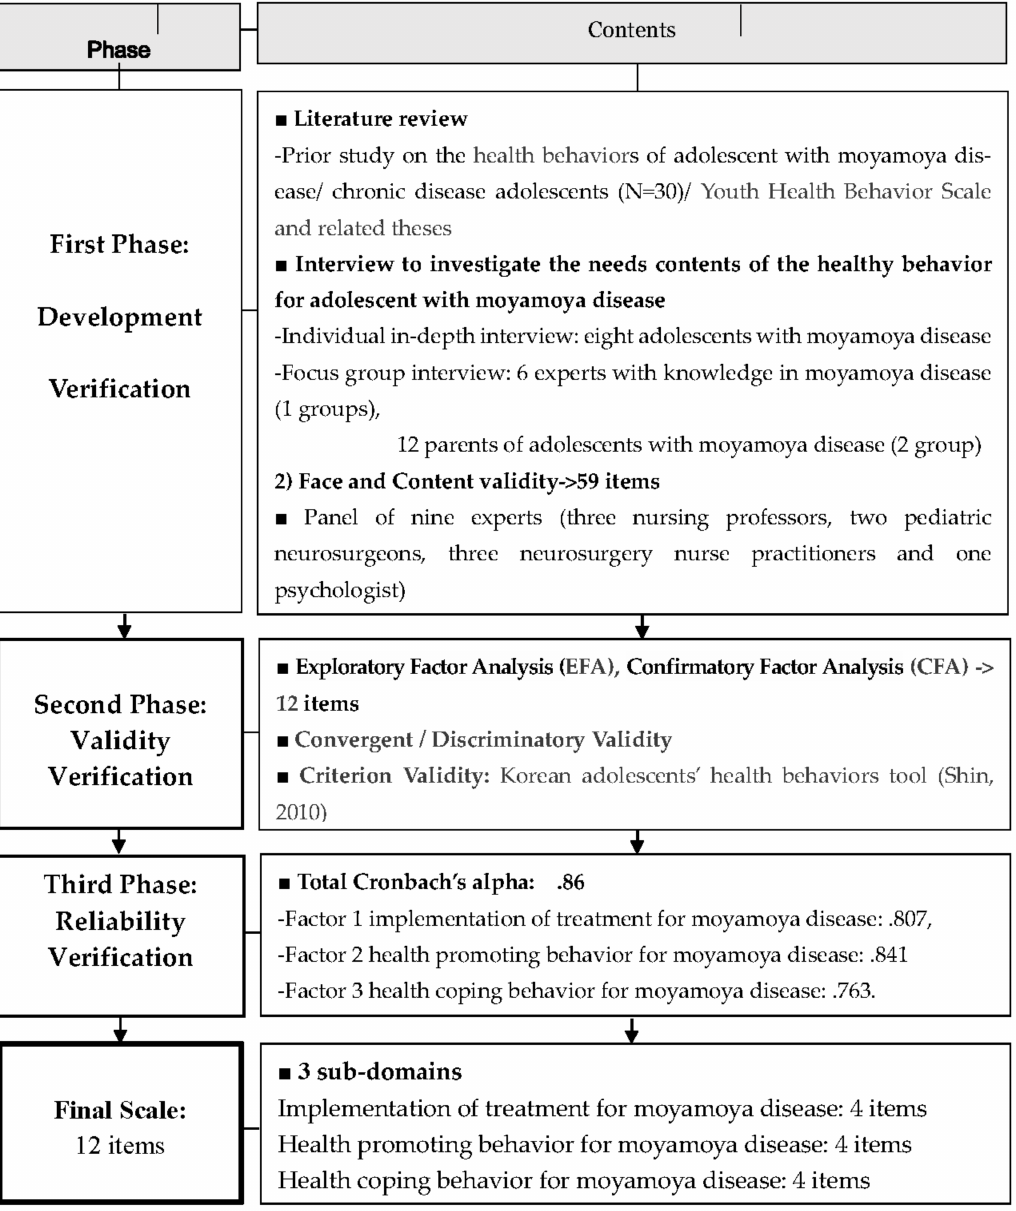
Figure 1. Process of program development and psychometric